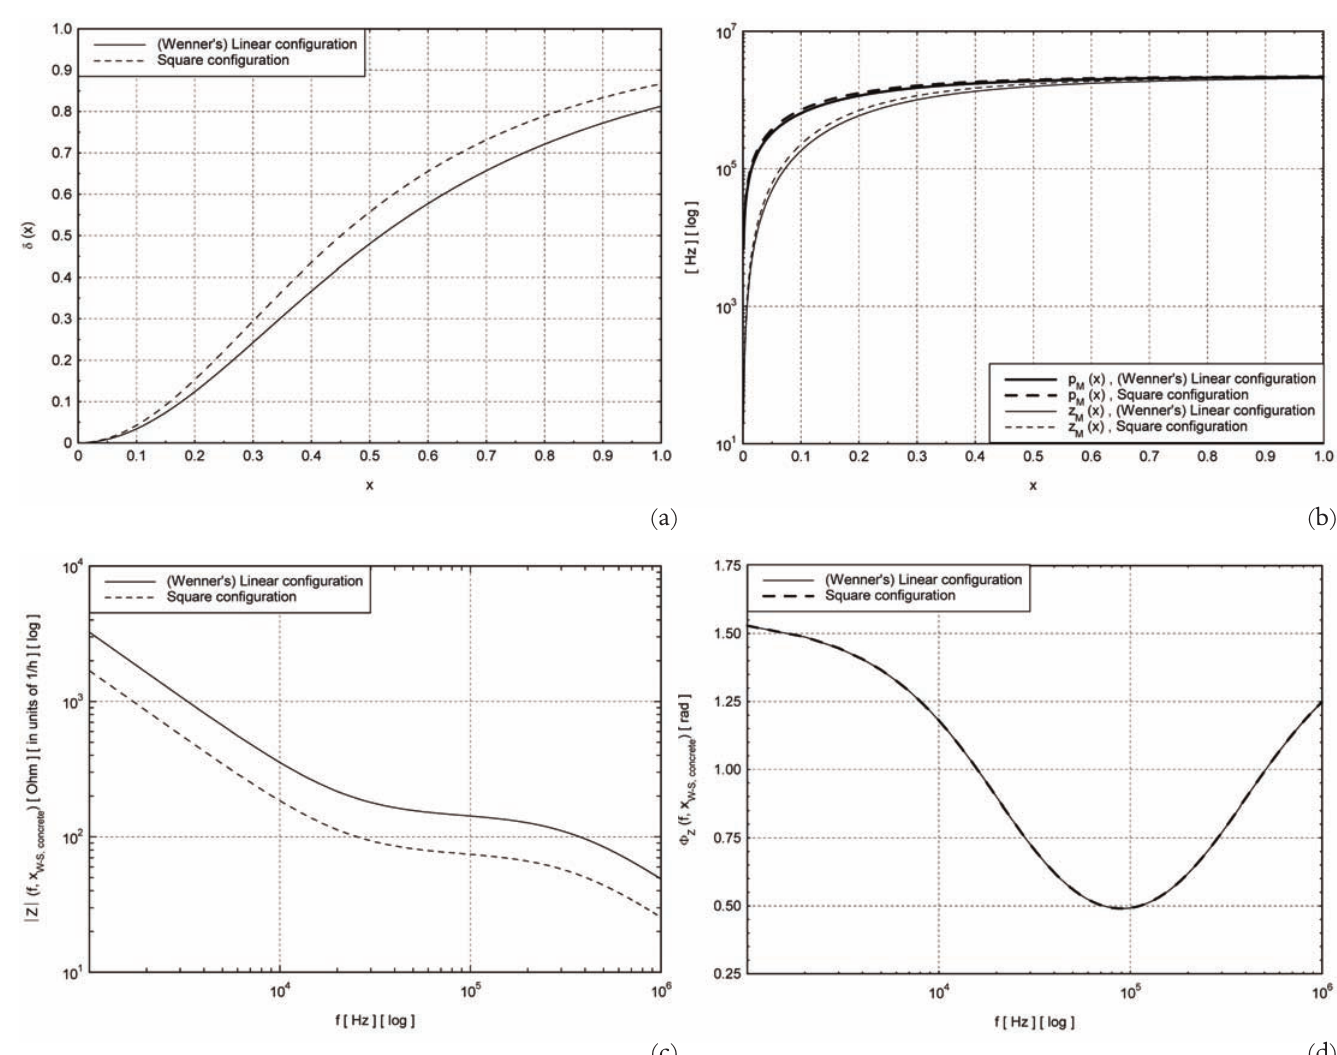
Figure 8. Referring to a quadrupole probe designed in the linear Wenner or square configurations and with capacitive contact on a non-saturated concrete of low electrical conductivity, i.e. v = 10 −4 S / m , f characteristic geometrical dimension L , with 0 < x ≤ 1, for the geometrical factor d ( x ); (b) semi-logarithmic plots for both the zero z of the transfer impedance in modulus; (c, d) Bode's diagrams, as a function of the frequency f in the band f ∈ [0, f impedance both in modulus | Z |( f , x semi-logarithmic plots for both the inaccuracies Df with the height/dimension ratio designed optimally in the linear Wenner ( x